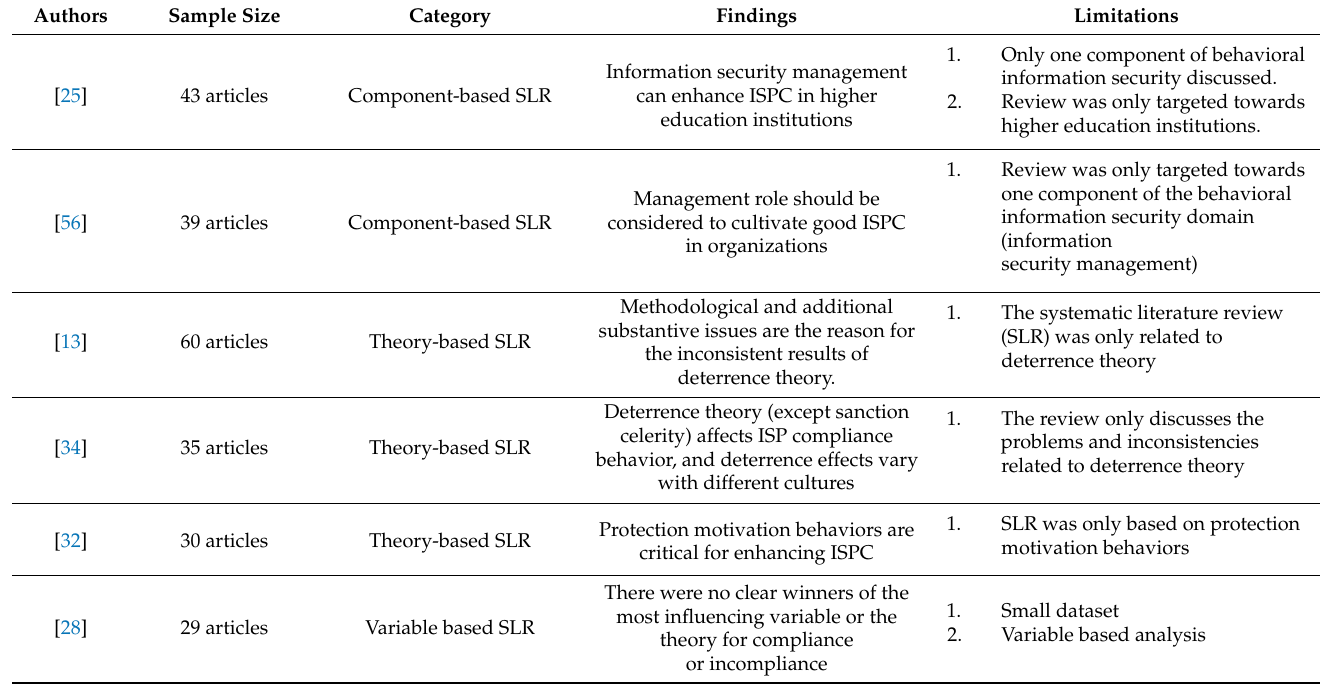
Table 1. Comparison with existing literature (limitations of existing reviews). Table 1. Cont.